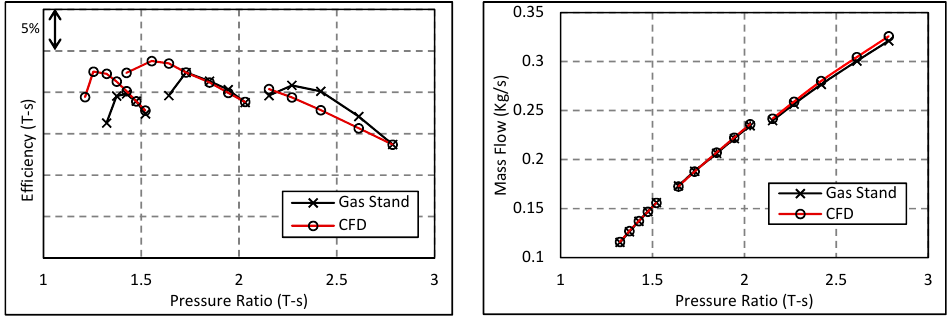
Figure 8. Comparison of steady state computational and gas stand results. ( Left ) efficiency (T-s) and ( Right ) mass flow.